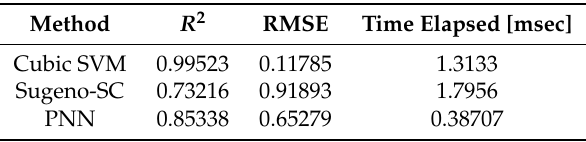
Table 2. Overall results for human pose estimation, obtained from the three methods presented in Section